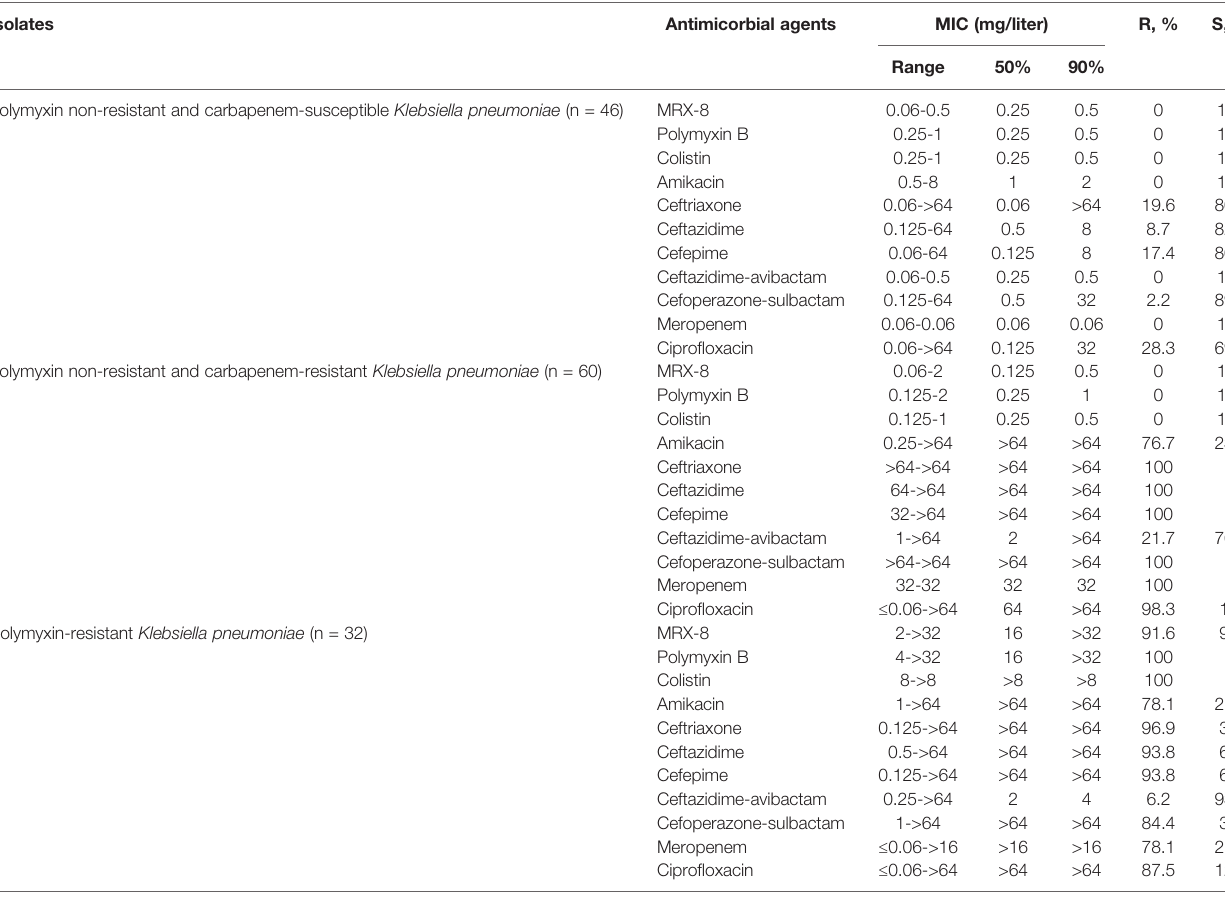
TABLE 2 | In vitro activity of MRX-8 and other comparator agents against 138 of Klebsiella pneumoniae (mg/L). Isolates Antimicorbial